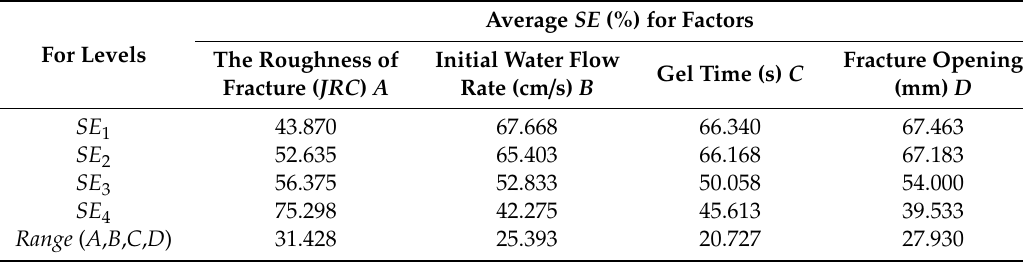
Table 5. Range analysis of the influence of different levels on the sealing effect.